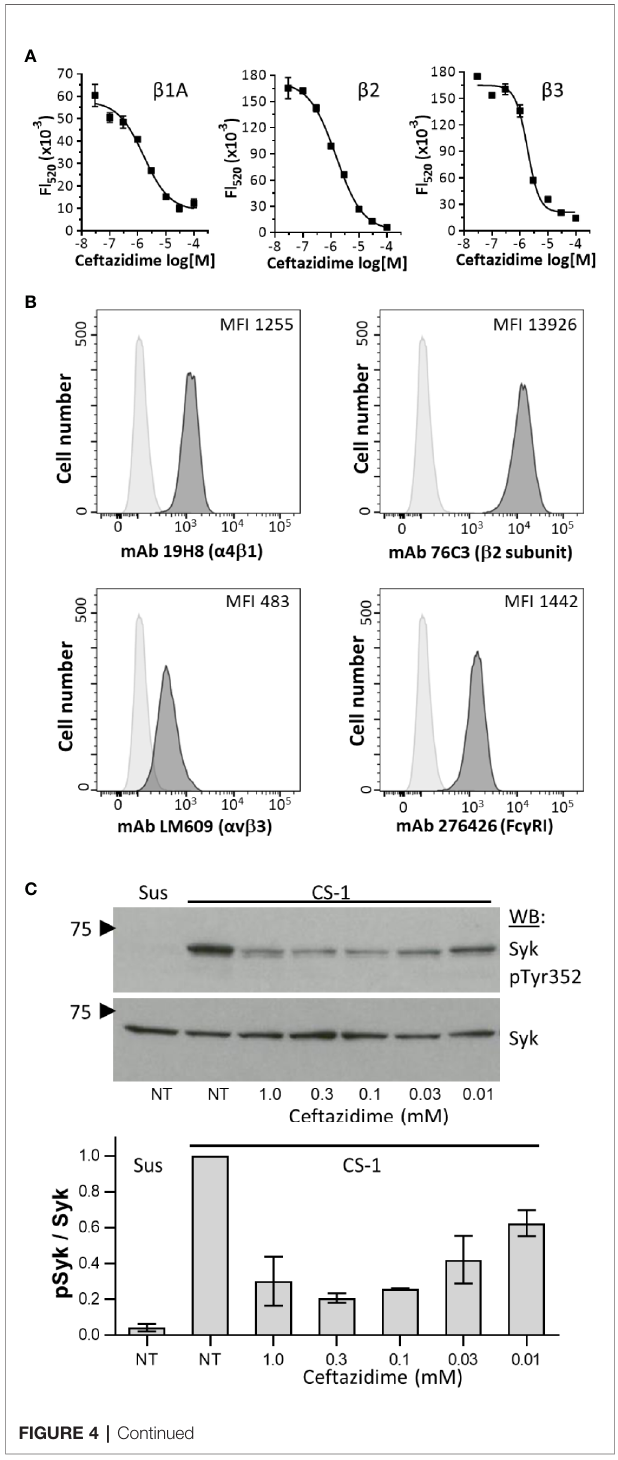
FIGURE 4 | Ceftazidime inhibition of integrin signaling. (A) Dose-response curves comparing ceftazidime antagonist activity against integrin b 1A, b 2, and b 3 cytoplasmic domains binding to Syk as measured in AlphaScreen assays. For all dose-response curves, biotinylated- b chain peptide was used at a fi nal concentration of 30 nM, and GST-Syk(6-370) was used at a fi nal concentration of 0.3 nM. Data are expressed as mean fl uorescence (Fl 520 ) ± the range from duplicate determinations. One of three experiments is shown. (B) Flow cytometric analysis of integrin a 4 b 1, b 2 subunit, a V b 3, and Fc g RI (CD64) on THP-1 cells. Isotype control staining is shown as light gray histograms. Speci fi c integrin staining is shown as darker gray histograms. One of three representative experiments is shown. (C) Dose-dependent effects of ceftazidime on integrin-dependent phosphorylation of Syk. Ceftazidime was loaded into THP-1 by glycerol shock. Control cells (NT) underwent glycerol shock but in the absence of drug. THP-1 cells were either maintained in suspension (Sus) or plated on plastic immobilized CS-1 conjugated to bovine serum albumin. After incubation at 37°C, whole cell lysates were separated by SDS-PAGE, probed for phosphorylated Syk (pY352, mAb 65E4), stripped, and then re-probed with monoclonal antibody 4D10 to determine total Syk levels. One representative blot is shown (top), along with quanti fi cation of three separate experiments normalized to maximum Syk phosphorylation (bottom). Results are expressed as the mean